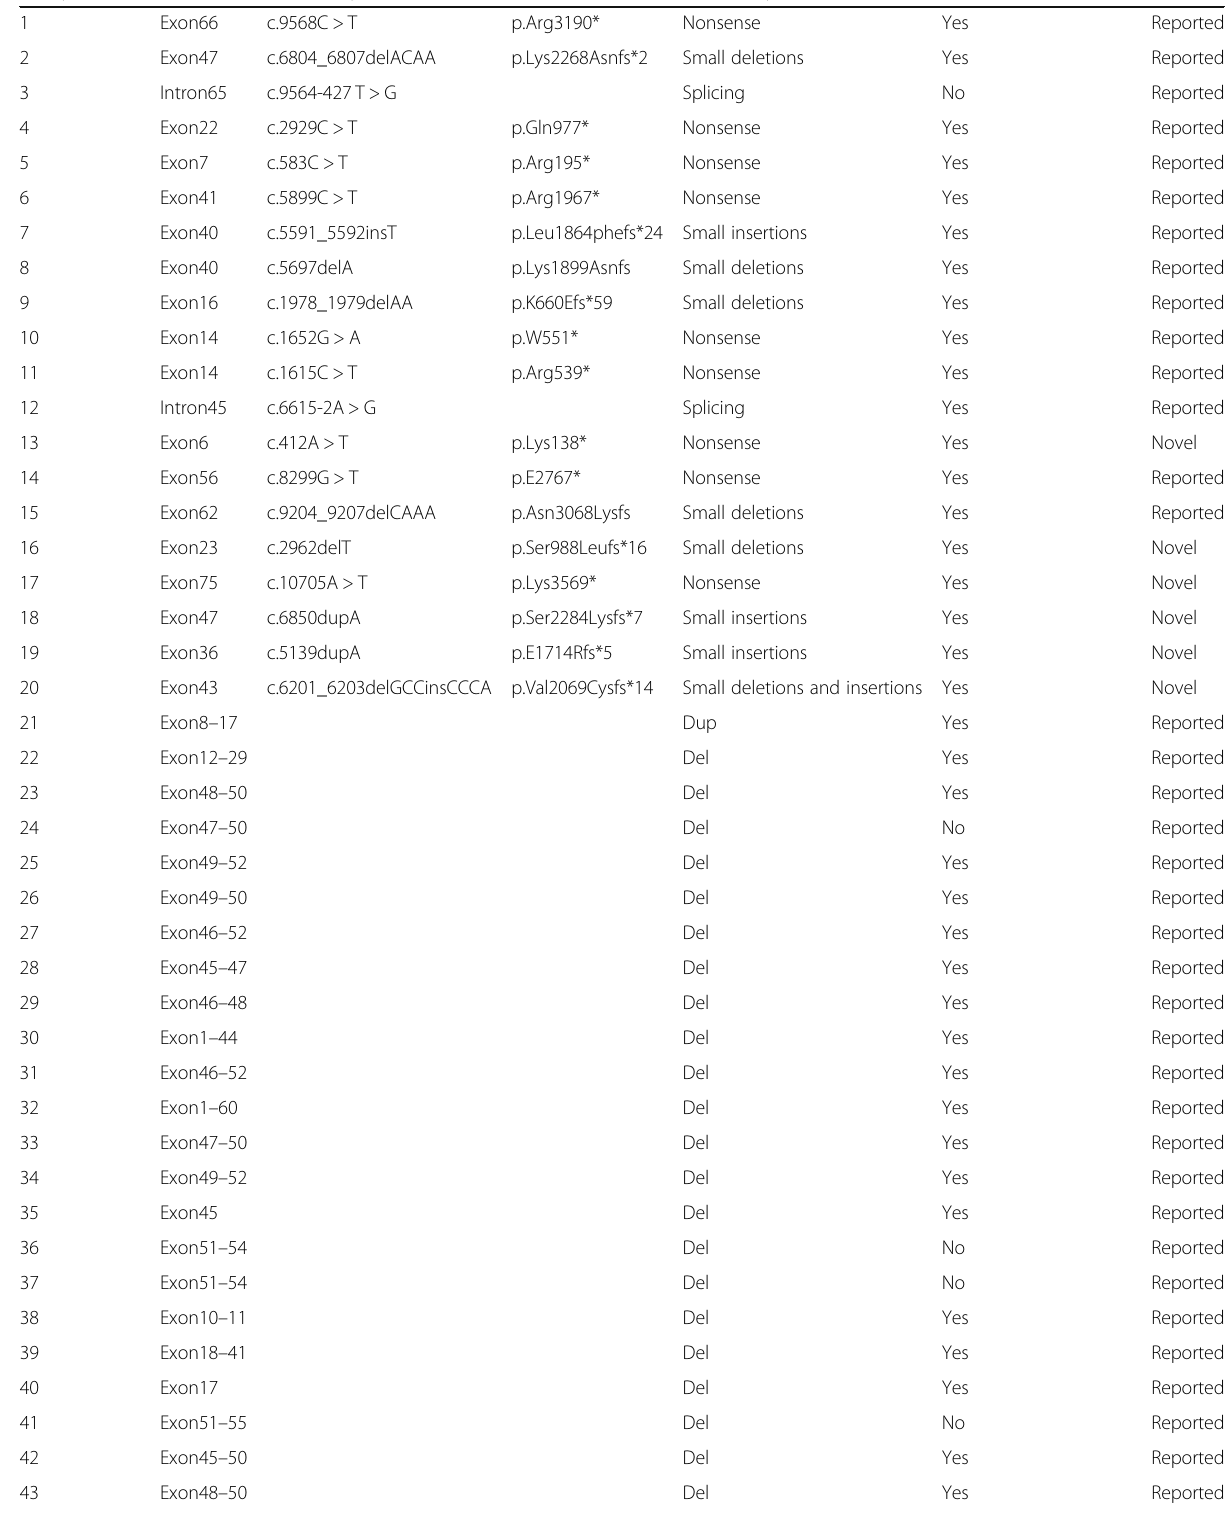
Table 1 The mutation spectrum of DMD patients in 52 families Family number Exon